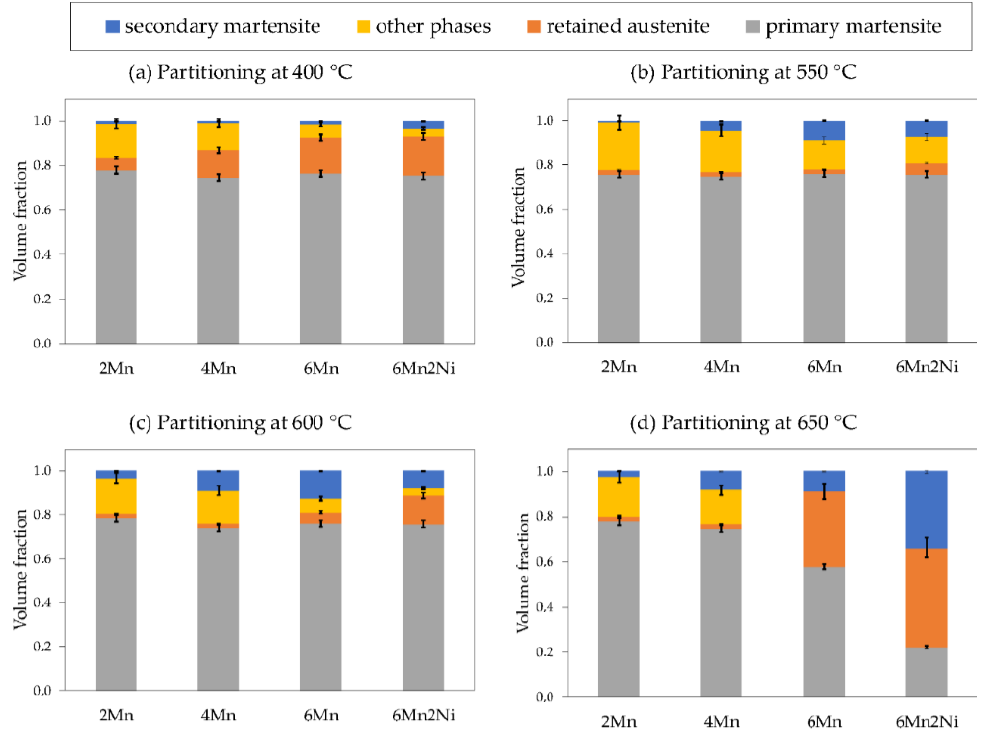
Figure 6. Volume fraction of phases after the application of ( a ) 400 °C; ( b ) 550 °C; ( c ) 600 °C; ( d ) 650 °C partitioning temperature cycles in alloys 2Mn, 4Mn, 6Mn, and 6Mn2Ni.